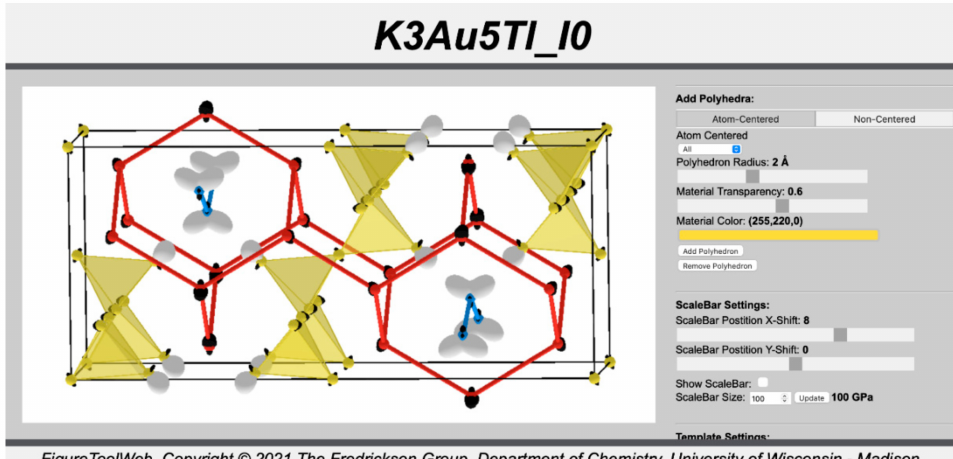
Figure 9. The addition of Au 4 polyhedra to the FigureToolWeb plot of the K 3 Au 5 Tl CP scheme.